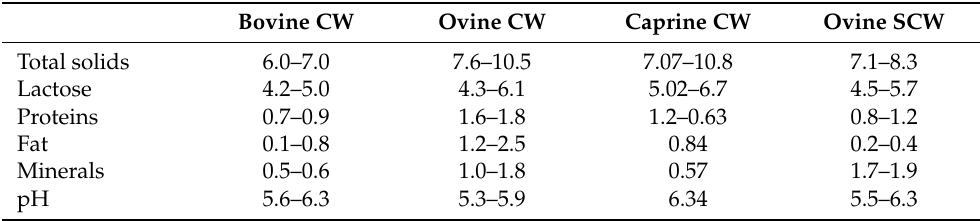
Table 1. Average composition of bovine, ovine and caprine whey and of ovine second cheese whey (% w / v ).